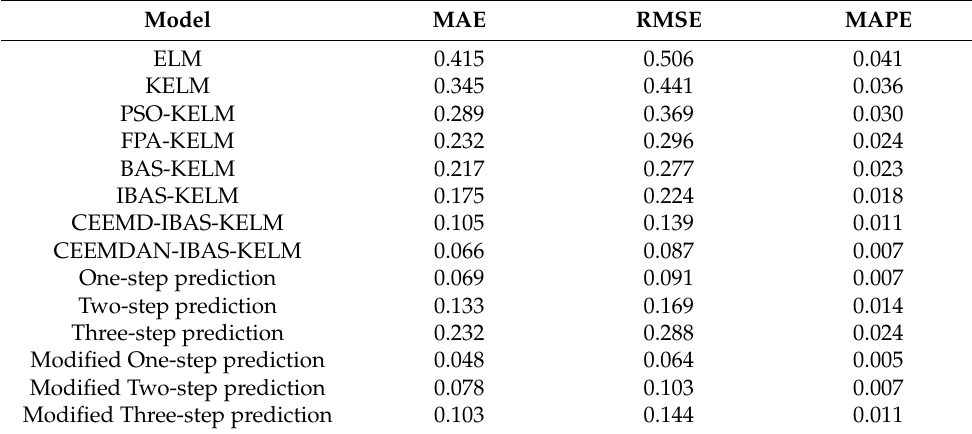
Table 5. Error evaluation indexes of each prediction